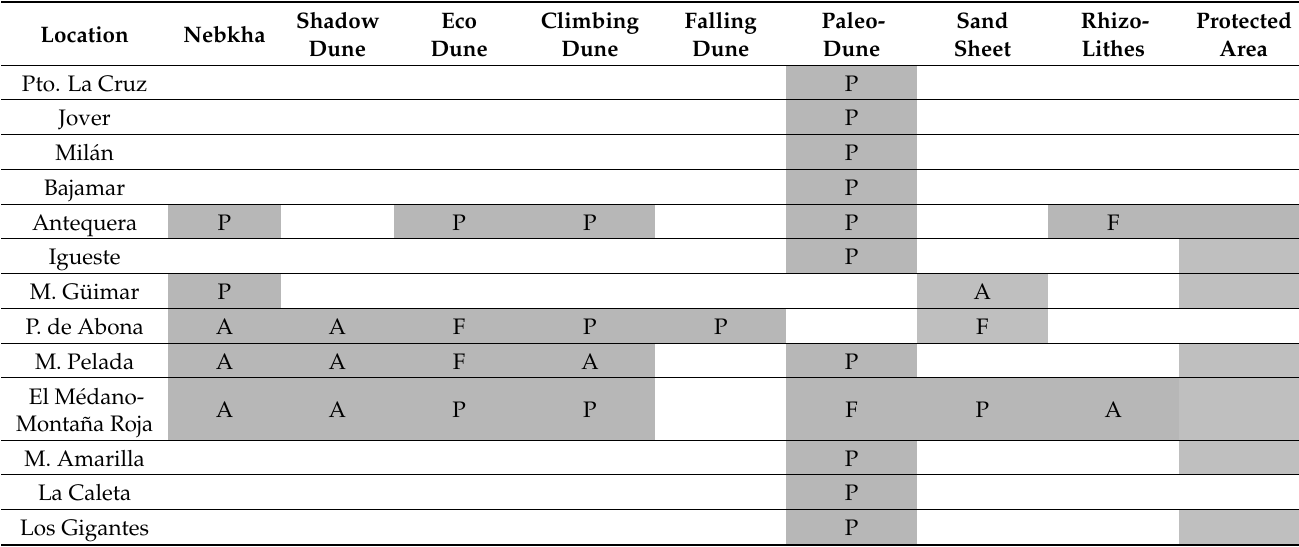
Table 2. The relative importance of aeolian landforms in the study area and their protection. P: present landform, F: frequent landform, A: abundant land form. The grey colour shows the presence of the item. Self-elaboration from